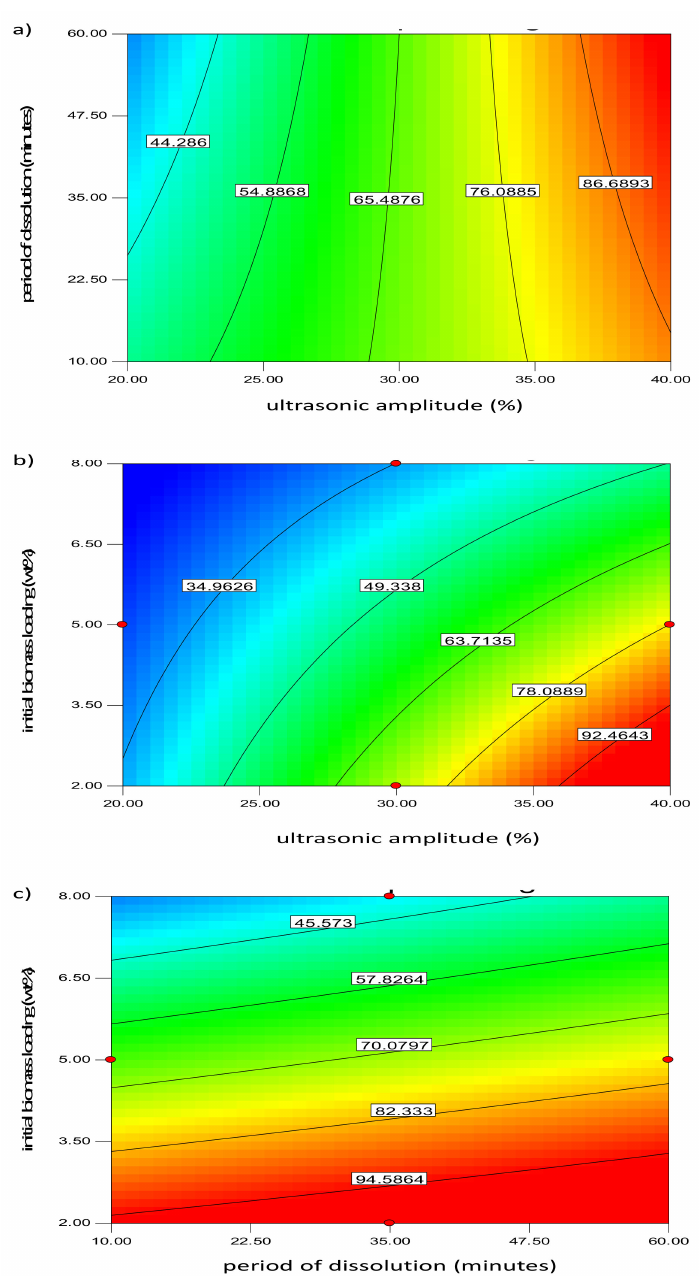
Figure 8. Contour plot for the effect of each parameter for bamboo dissolution in MOE-MImCl; ( a ) plot of period of dissolution against ultrasonic amplitude, ( b ) plot of initial biomass loading against ultrasonic amplitude and ( c ) plot of initial biomass loading against period of